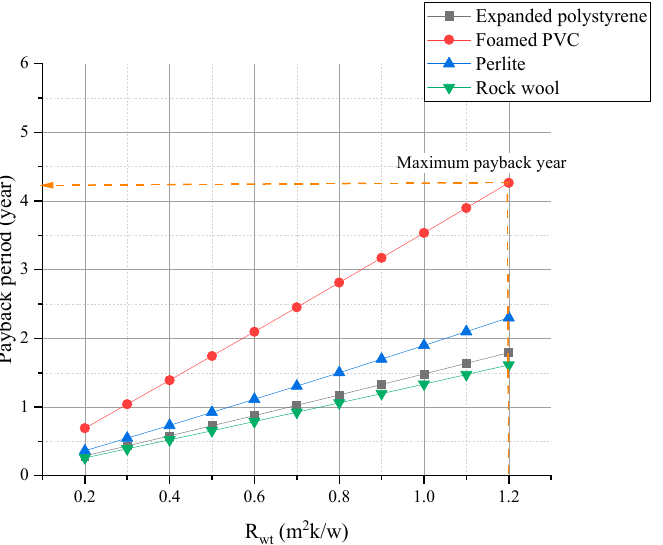
10 of 15 Figure 7. The effect of R wt on the optimum thickness of insulating materials. Figure 8 shows the effect of R wt on the payback period for different insulating mate- rials at the optimum thickness. It can be found the payback period appears linearly with the increase in R wt and the increase rates are different in four insulating materials. As the